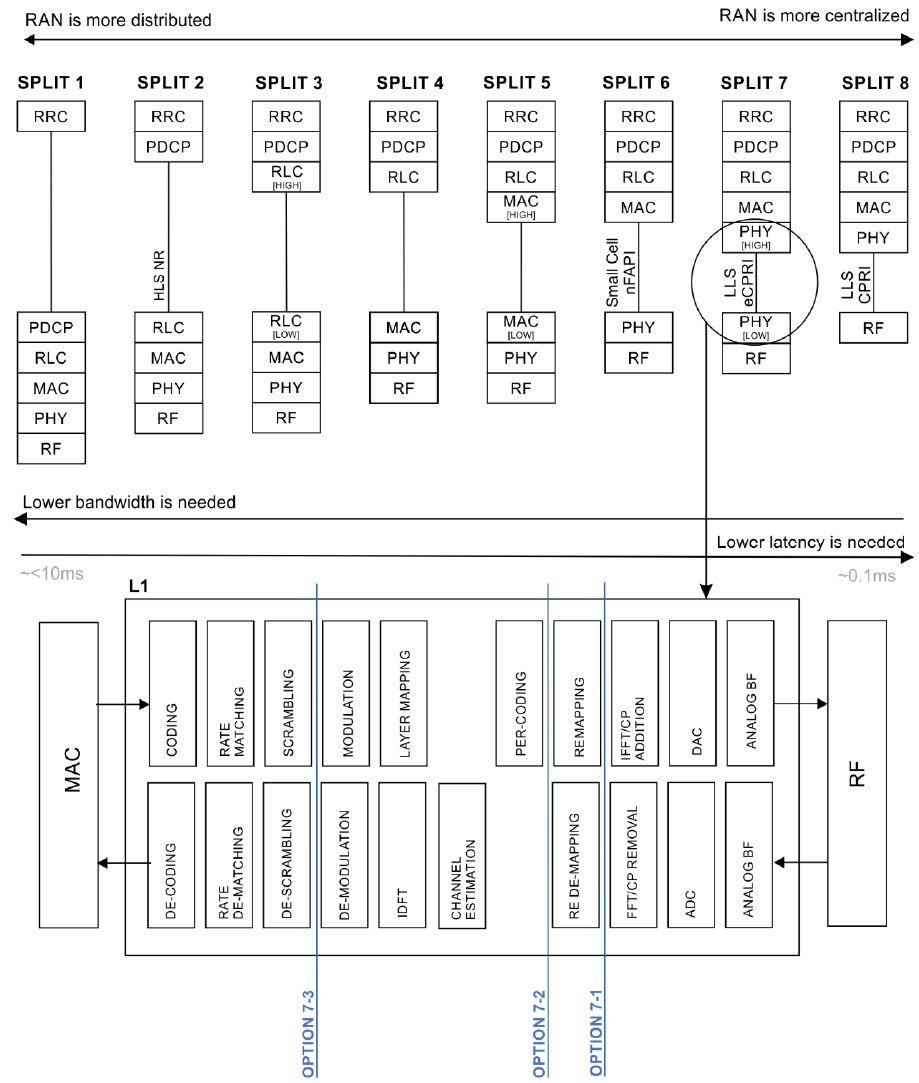
Figure 2. Review of functional splitting options with respect to 3GPP 4G/5G RAN stack (above) and differences among Option 7 split from PHY layer perspective.